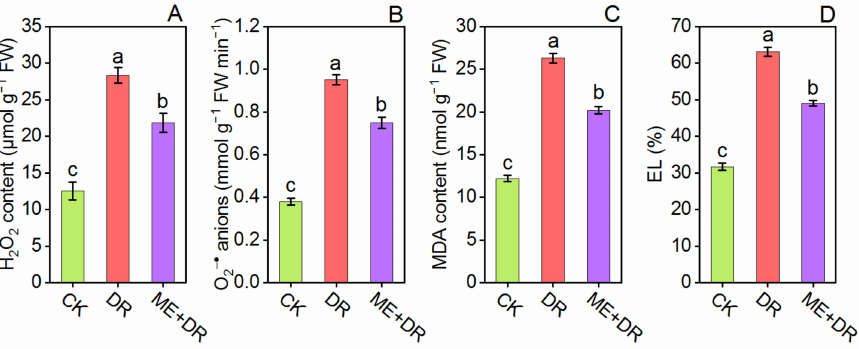
Figure 6. Exogenous supplementation of melatonin reduces oxidative damage biomarkers [H 2 O 2 content ( A ), O 2 •− anions ( B ), MDA content ( C ), and EL ( D )] of tomato seedling under drought stress conditions. Means ± standard error, n = 3, significant difference is exhibited by lowercase letters ( p ≤ 0.05), according to LSD